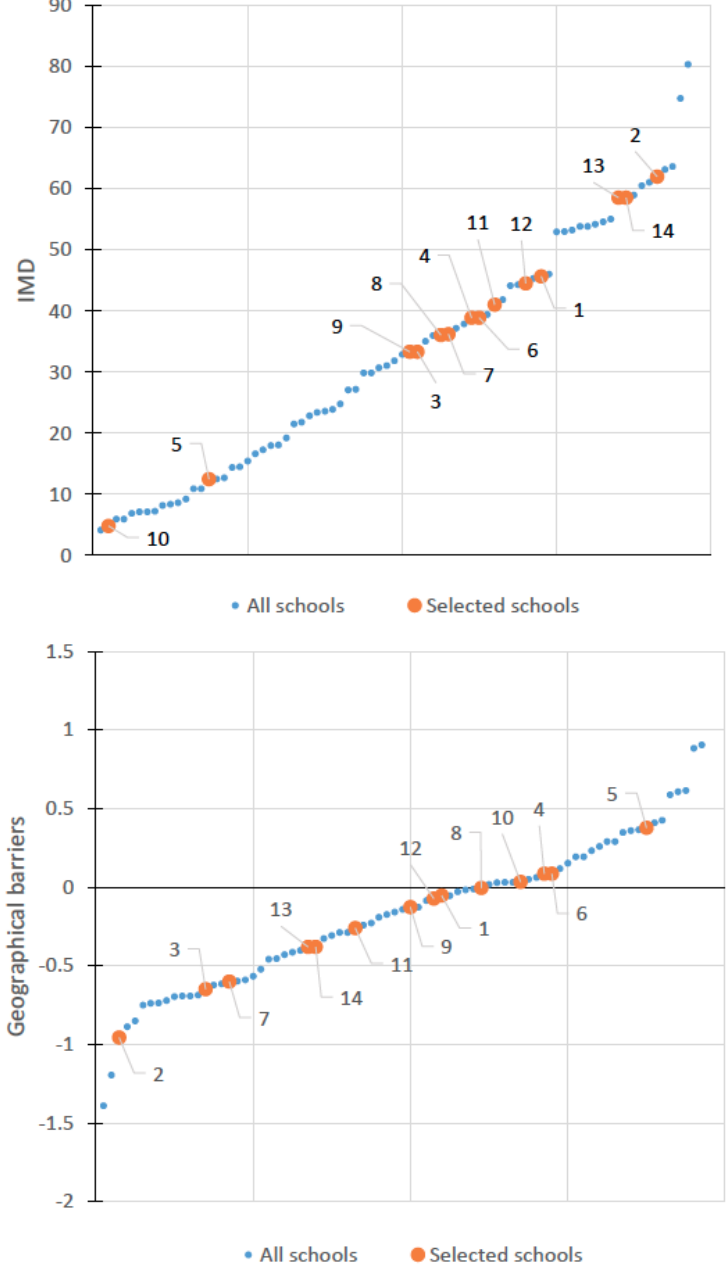
Figure 2. Two rank plots of the 14 Liverpool schools participating in the workshops (highlighted points) and of all state sec- ondary schools in Merseyside (non-highlighted points). The y-axis denotes the values of the Index of Multiple Deprivation (IMD, top) and of the Geographical Barriers sub-domain (bottom), with high values meaning highly-deprived LSOAs; the x- axis denotes each LSOA rank value. IMD reveals a cluster of schools located within LSOAs of moderate IMD scores, with outliers in low- and high-deprivation areas. IMD sub-domains such as Geographic Barriers (bottom) reveal a more even distribution of sampled schools, although deprivation levels generally correlate to accessibility